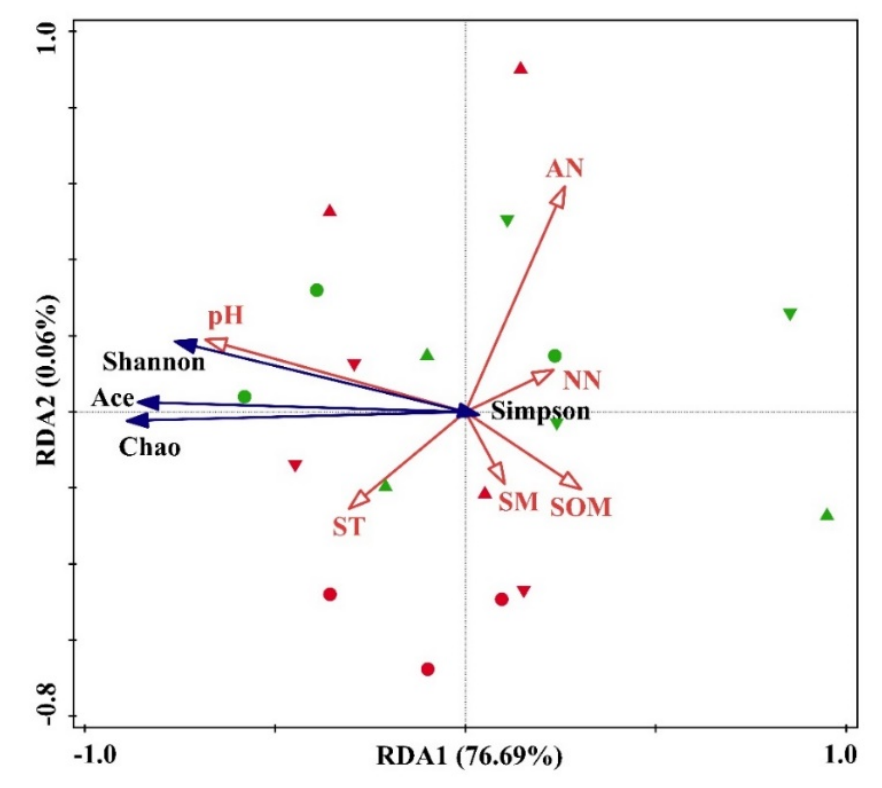
Figure 4. Redundancy analysis (RDA) was used to investigate the relationships between the diversity of bacterial communities (expressed as blue arrows) and soil environmental factors (expressed as red arrows). ST: soil temperature; SM: soil moisture; pH: soil acidity; SOM: soil organic matter; AN: ammonium nitrogen; NN: nitrate nitrogen.